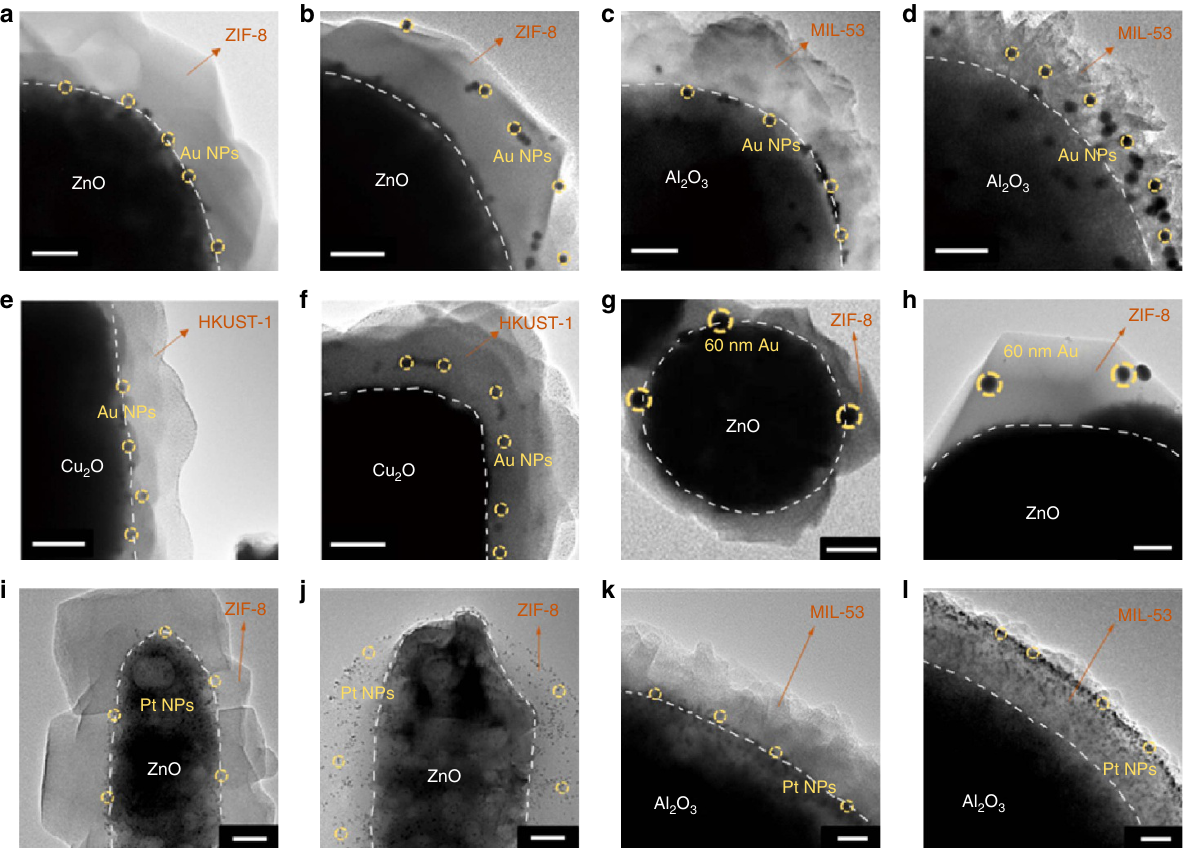
Figure 3 | The controllable encapsulation of various MNPs in different MOFs with corresponding metal oxides as templates. TEM images of 13nm Au NPs@MOF composites obtained under two ligand concentrations: ( a , b ) ZIF-8 with ZnO spheres as template, ( c , d ) MIL-53 with Al 2 O 3 spheres as template and ( e , f ) HKUST-1 with Cu 2 O cubes as template. TEM images of various types of MNPs@MOF composites: ( g , h ) 60nm Au NPs in ZIF-8 with ZnO spheres as template, ( i , j ) 3.3nm Pt NPs in ZIF-8 with ZnO nanorods as template and ( k , l ) 3.3nm Pt NPs in MIL-53 with Al 2 O 3 spheres as template. Scale bar, 200nm ( a – h ), 50nm ( i , j ) and 20nm ( k , l ), respectively. In pairs of images, the higher ligand concentration appears on